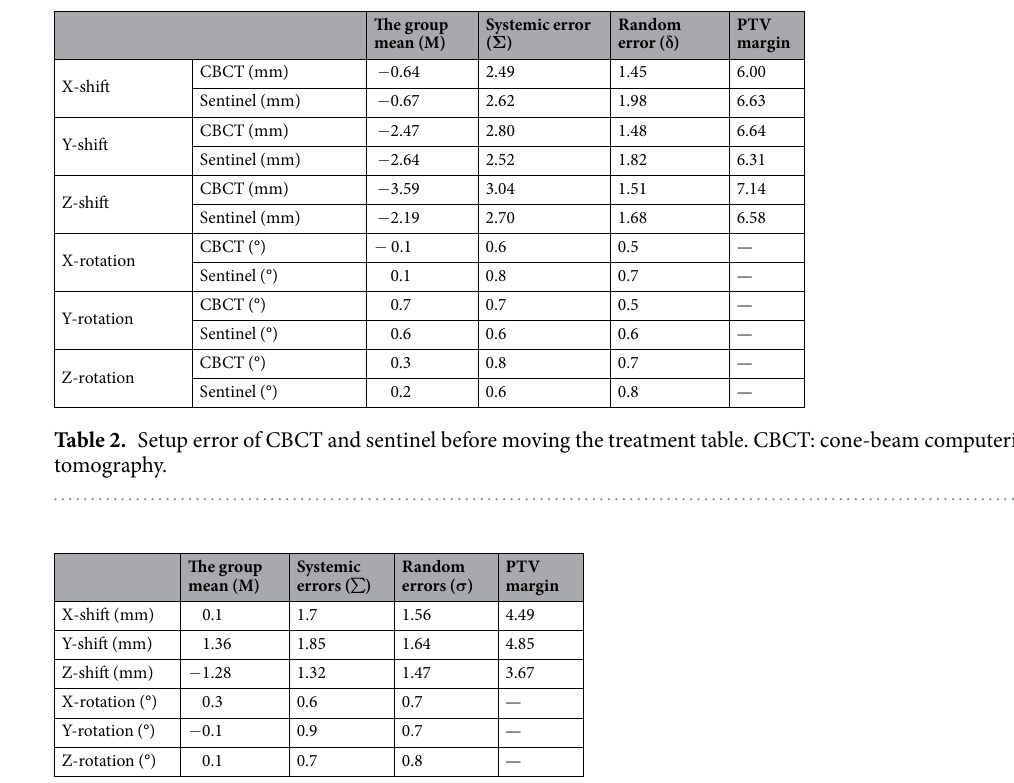
Table 3. Residual setup error of Sentinel. PTV: planning target